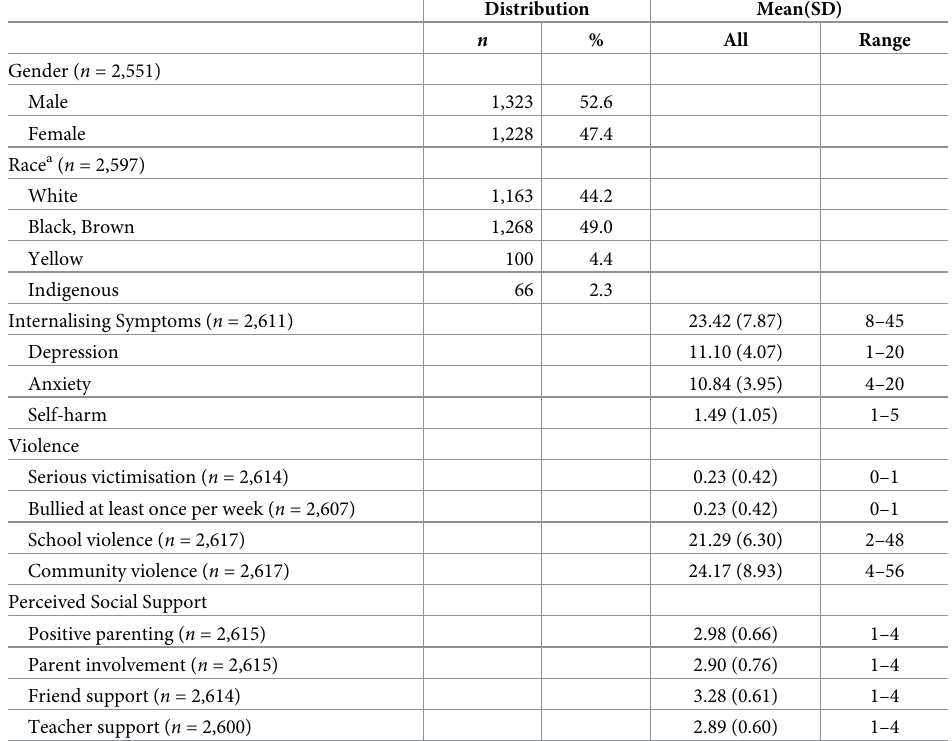
Table 1. Characteristics of study participants and mean of internalising symptoms, violence, and social support among study participants (weighted).